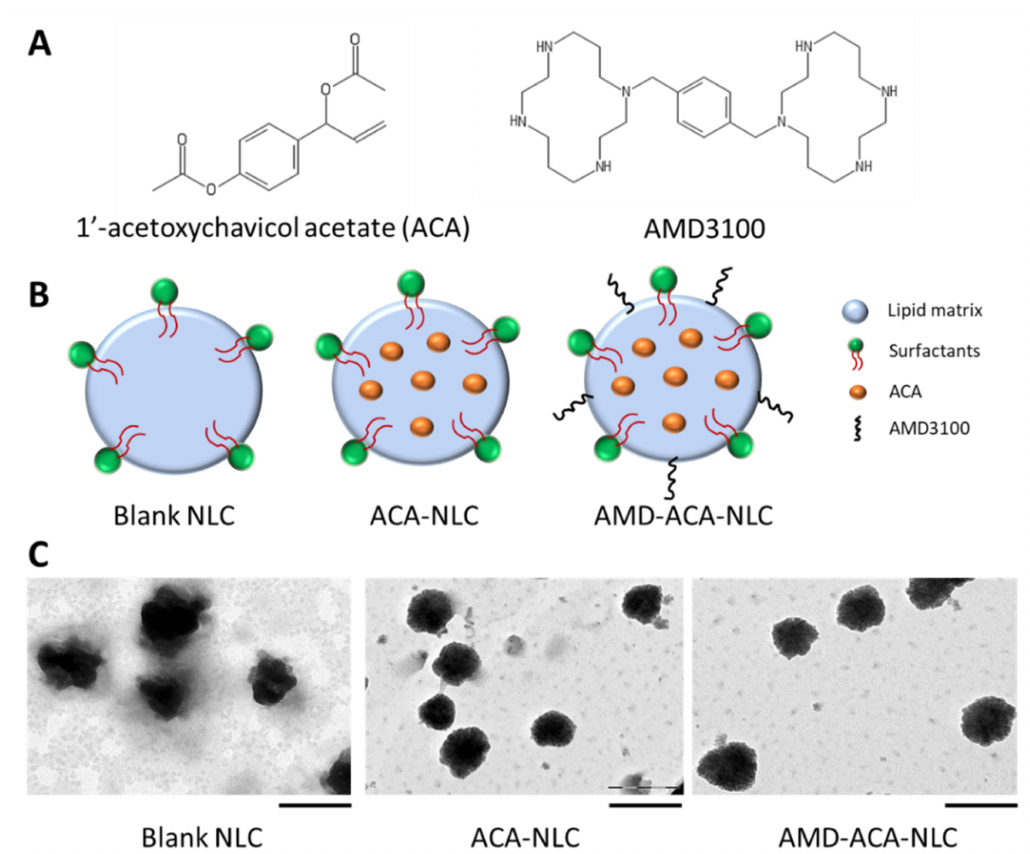
Figure 1. ( A ) Chemical structure of 1 (cid:48) -acetoxychavicol acetate (ACA) and AMD3100. ( B ) Schematic drawings representing blank NLC, ACA-NLC, and AMD-ACA-NLC. ( C ) TEM images of blank NLC, ACA-NLC, and AMD-ACA-NLC. Scale bar = 200 nm.